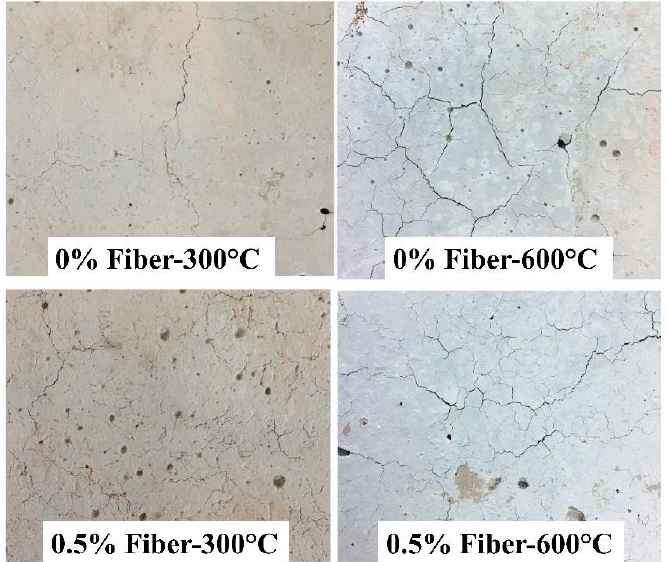
Figure 20. The surface condition of BF based FRAC demonstrates physical appearance and crack development at 300 °C and 600 °C. Copyright permission is obtained from